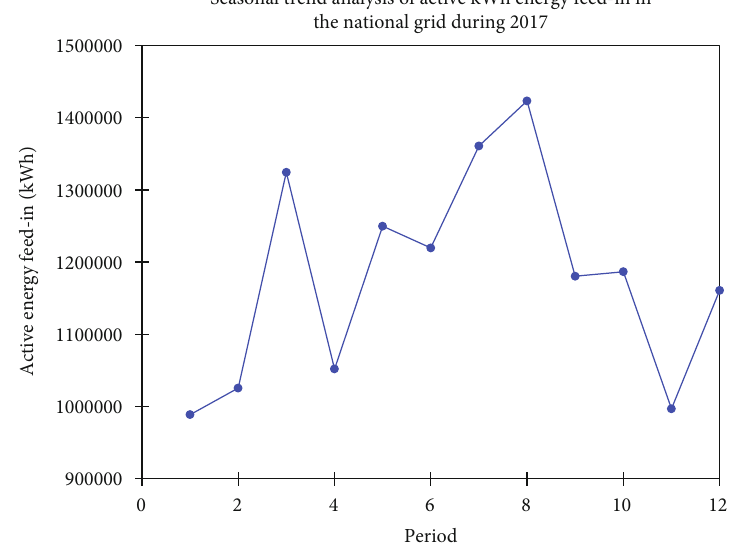
Figure 5: Seasonal Mann-Kendall Trend Test analysis of active kWh energy feed-in in the national grid during 2017.